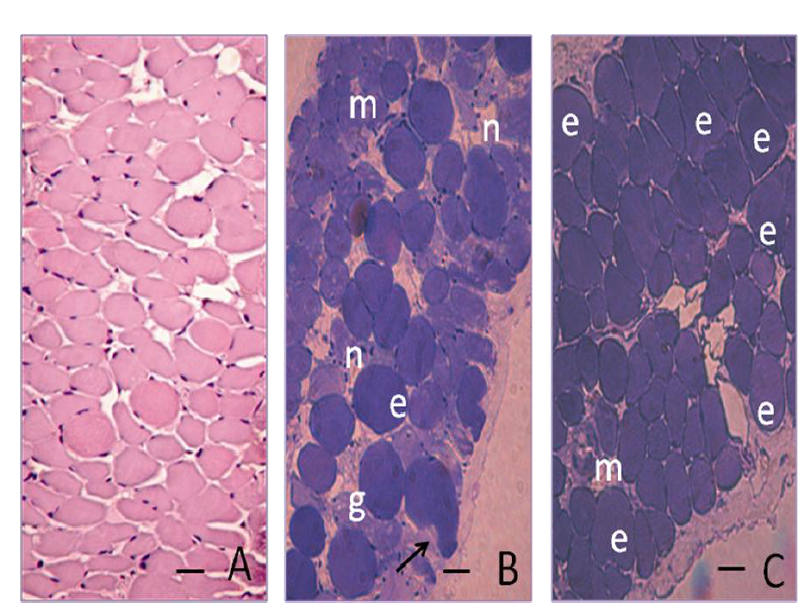
Figure 5. Cross-sections (2 μm thick) of diaphragm after a 120 min incubation and indirect stimulation though the phrenic nerve. (A) Control-sham diaphragm preparation of paraffin embedded sections stained with Hematoxylin-Eosin. (B and C) Preparations embedded in historesin and stained with Toluidine blue. (B) Muscle incubated with 40 μg/mL Bjssu venom shows 56 ± 6% of fibers exhibiting various myonecrotic ( m ) states characterized by edema ( e ), delta lesion ( arrow ), presence of vacuoles, atrophy of the muscle fibers, sarcolemmal disruption with nuclei ( n ) dispersion, and “ghost” cells ( g ) visualized by spaces optically empty. Area with extensive myonecrosis assumed a hyaline aspect. (C) Muscle incubated with 40 μg/mL Bothrops jararacussu (Bjssu) venom plus methanolic extract shows fibers maintaining its characteristic polygonal profile, despite a number of them were edematous ( e ). A slow percentage of them (17 ± 2%) showed myonecrosis ( m ). Bar = 50